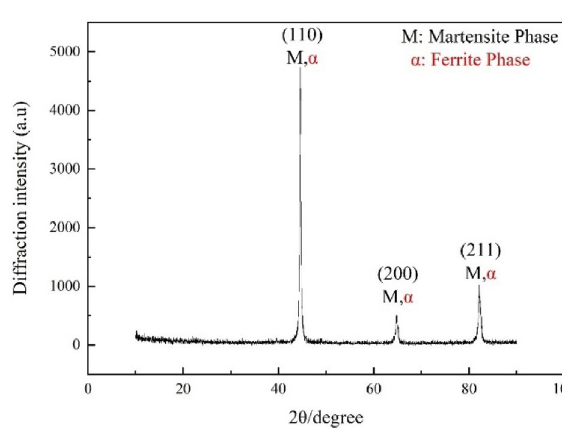
Figure 1. XRD spectra of the treated 35CrMo steel.